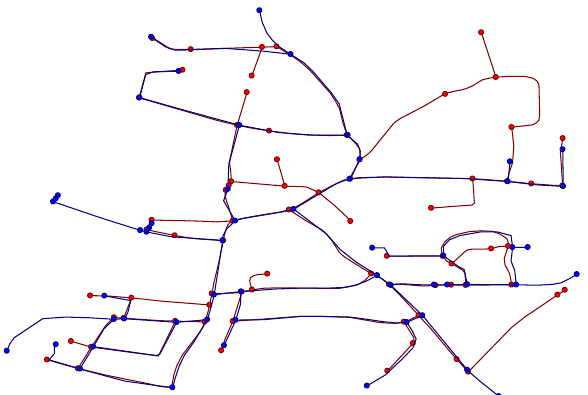
Figure 1: Overlay of two maps of the same region (red: ATKIS, blue: